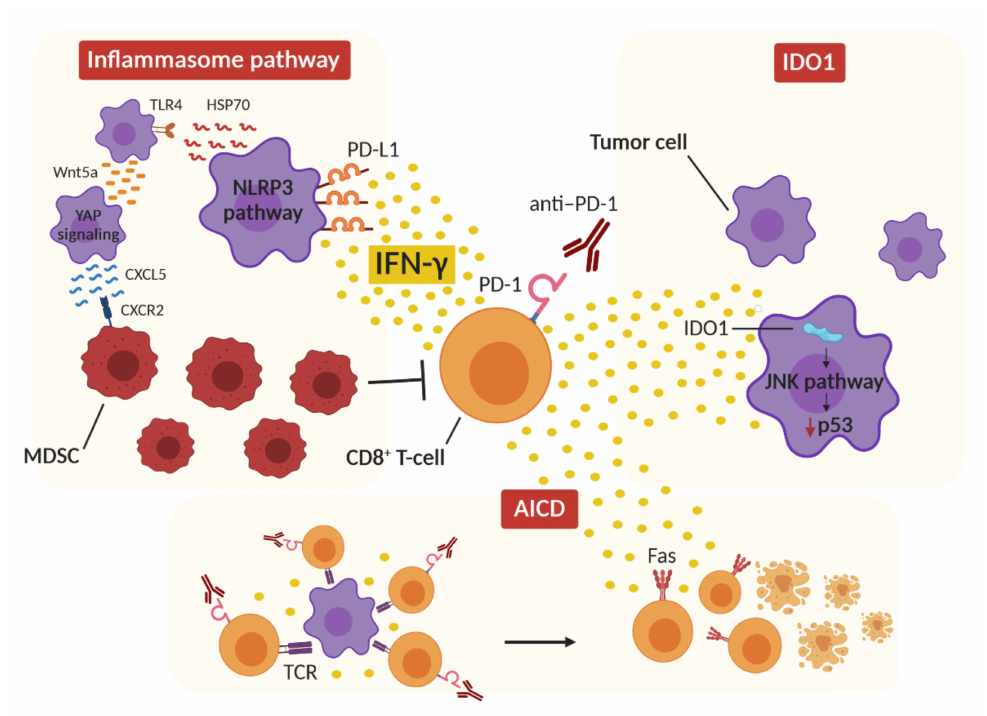
Figure 2. Proposed IFN- γ -dependent mechanisms of hyperprogression. The release of IFN- γ from CD8 + T cells after ICI therapy can activate the inflammasome pathway by upregulating PD-L1 expression on tumor cells and activating NLRP3 signaling, resulting in immunosuppressive MDSC recruitment in the tumor microenvironment. At the same time, IFN- γ can induce IDO1 activity in tumor cells, which activates the JNK pathway, leading to p53 downregulation and tumor growth. Finally, the concomitant stimulation of tumor-specific CD8 + T cells by ICI therapy and T-cell-receptor (TCR) activation results in a hyperactivated immune environment in which IFN- γ triggers the activation-induced cell death (AICD) mechanism and T-cell Fas-mediated